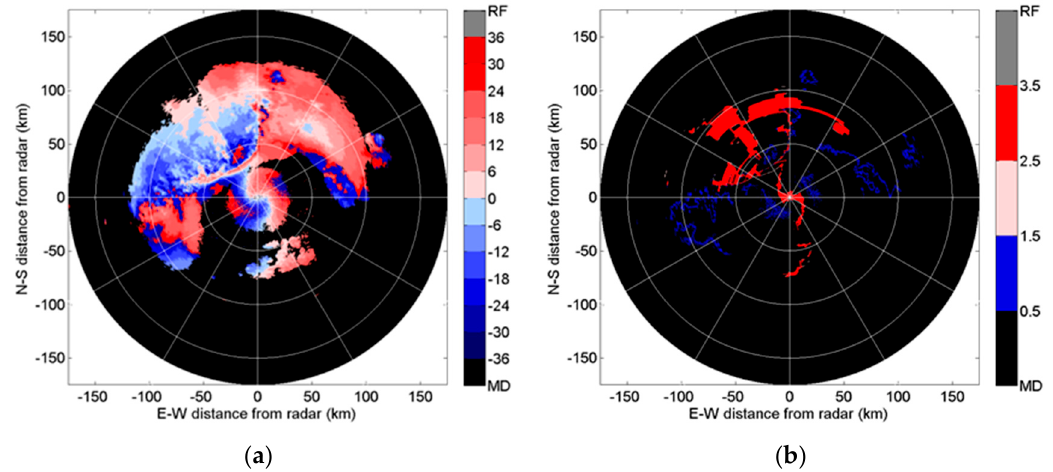
Figure 1. ( a ) Raw radar radial velocities of the elevation angle of 6.0° of Guangxi radar station at 2028 (UTC), 30 March, 2014. ( b ) The number of flags resulting from the procedure of preserving the convection regions at the same elevation angle of the same radar. Flag 1 denotes the boundary of the aliased area. Flag 3 shows the real shear regions.